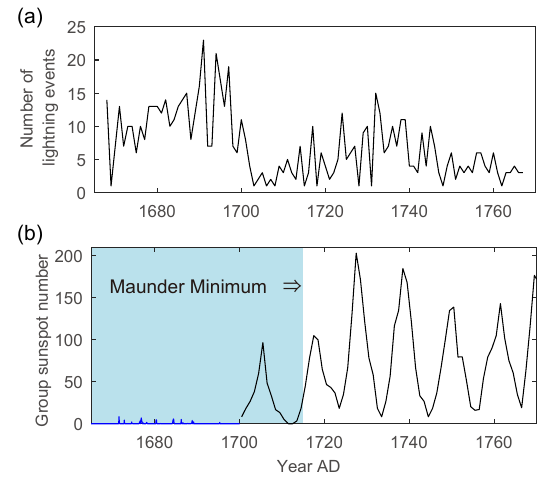
Figure 3. (a, b) Time series of group sunspot numbers for AD1716–1767. The red and blue shading defines the periods of so- lar maxima and minima, respectively, used in the analyses. (c) Pe- riodicity of lightning events during solar maxima. The red dashed lines denote 2 and 3SD. The red shaded bar indicates the 27–30-day period. (d) Same as in panel (c) but for solar